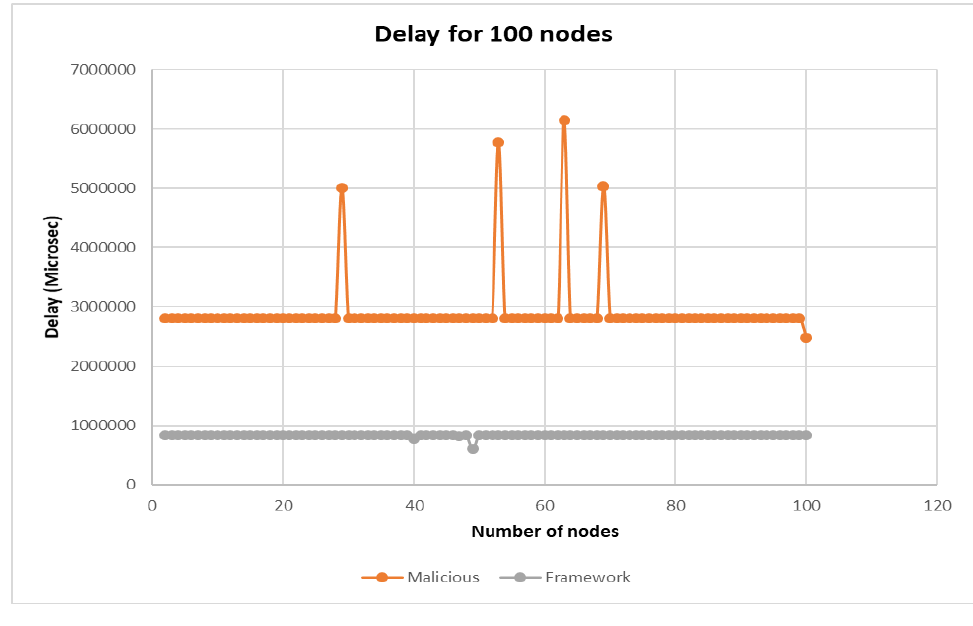
Figure 19. Delay for 100 nodes.